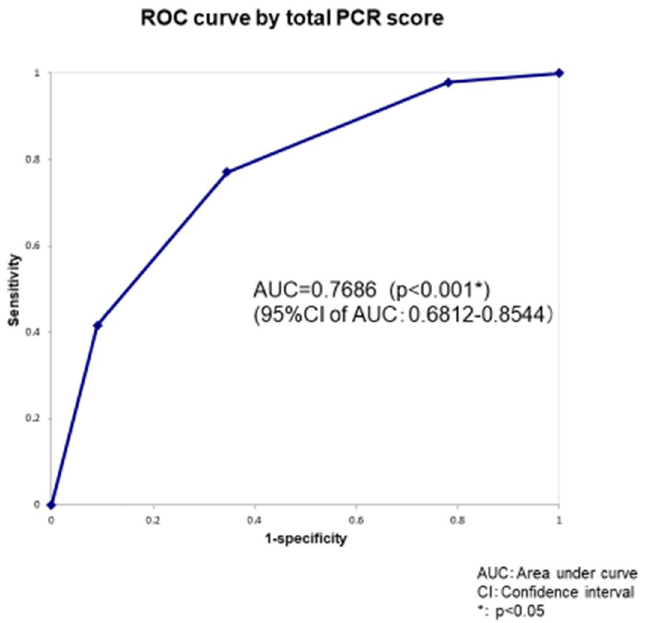
Figure 2. Receiver operating characteristic (ROC) analysis and diagnostic performance of PCR score for predicting 3-month mortality. The area under the ROC curve showed that PCR score successfully predicted survivors and nonsurvivors (AUC (c-index) = 0.7686; 95% CI 0.6812–0.8544; P < 0.001).